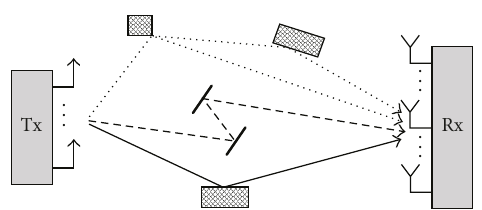
Figure 6: Example of finite scatterer model with single-bounce scattering (solid line), multiple-bounce scattering (dashed line), and a “split” component (dotted